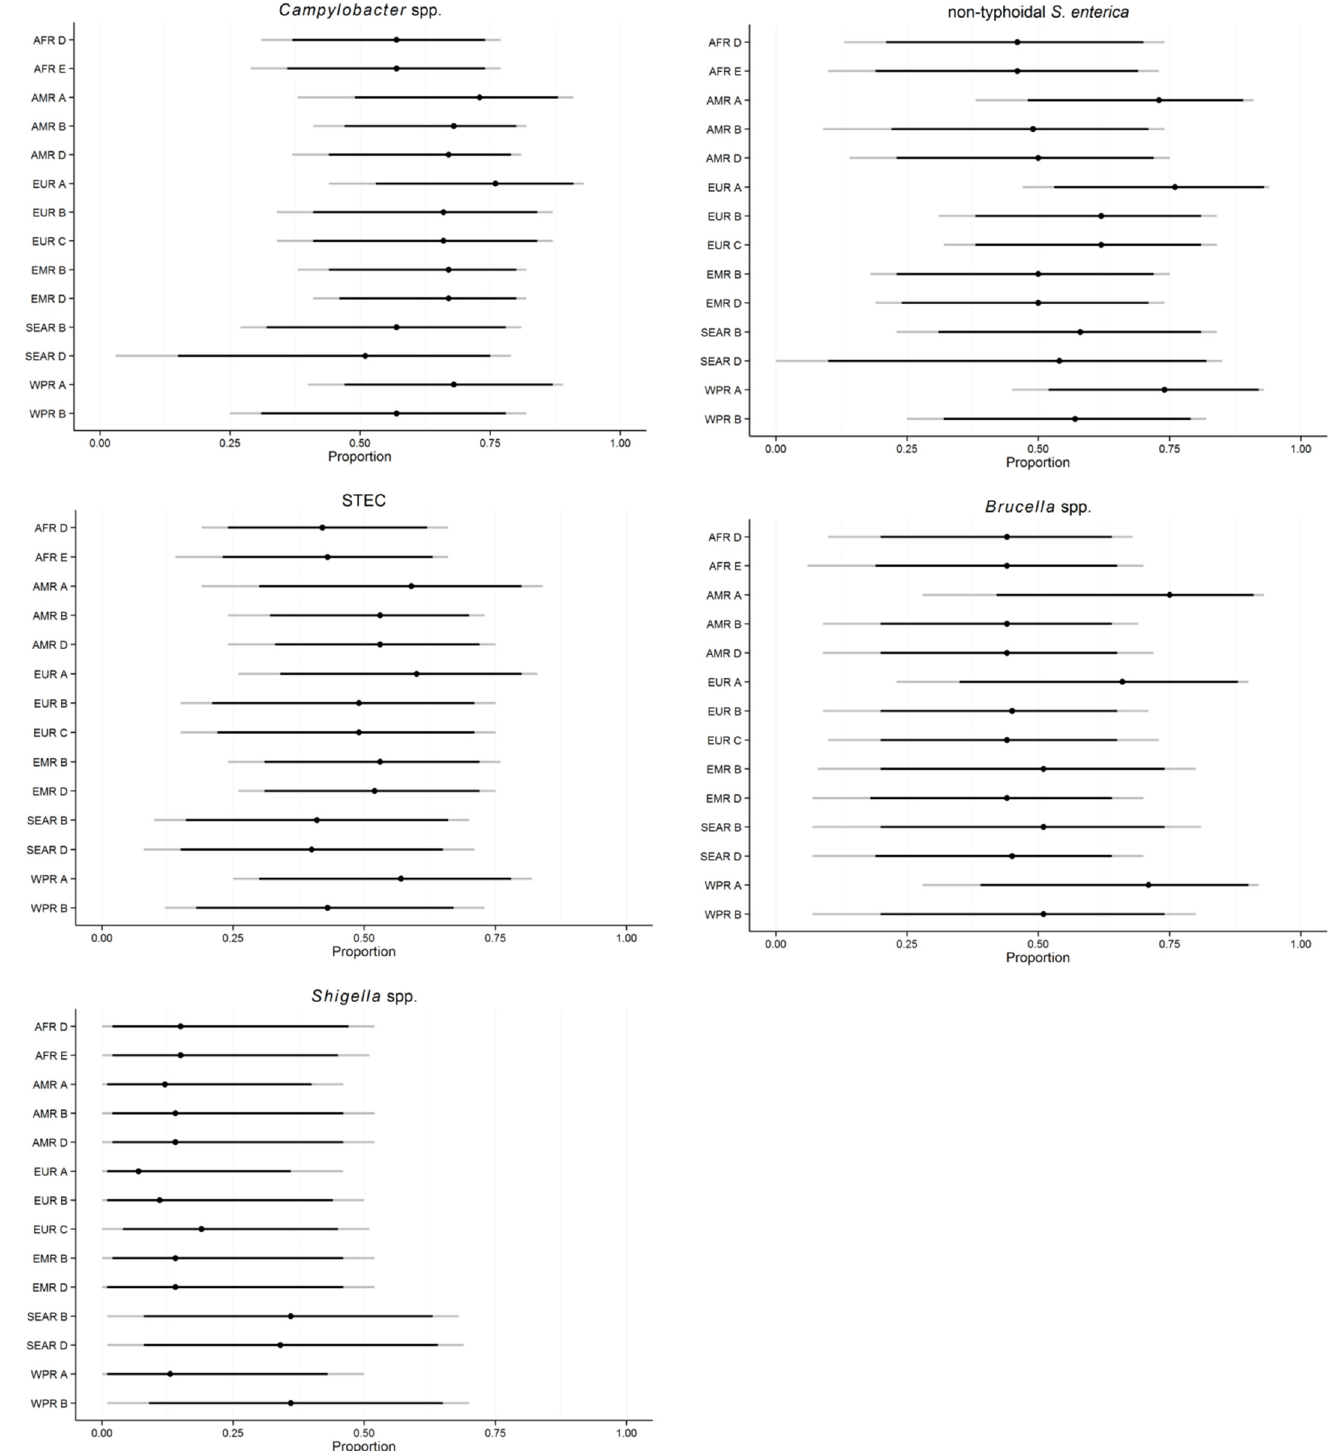
Fig 3. Subregional estimates of the proportion of foodborne illnesses caused by Campylobacter spp., non-typhoidal Salmonella spp., Shiga toxin- producing Escherichia coli (STEC), Brucella spp. and Shigella spp. Indicated on the line plot are the 2.5 th , 5 th , 50 th , 95 th and 97,5 th percentiles.